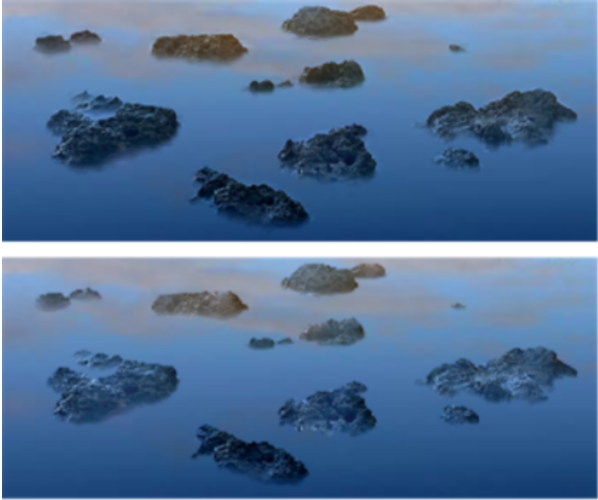
Fig. 9 Composition using patch-based synthesis (above) and pixel-based synthesis (below). Patch-based synthesis provides richer texture